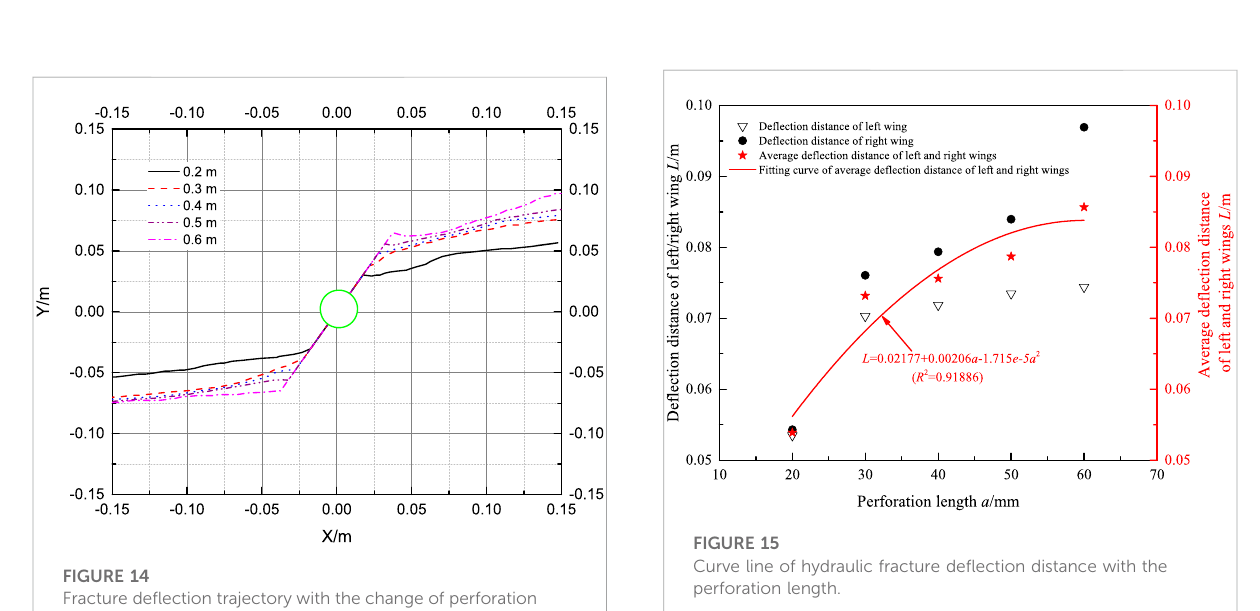
FIGURE 15 Curve line of hydraulic fracture de fl ection distance with the perforation